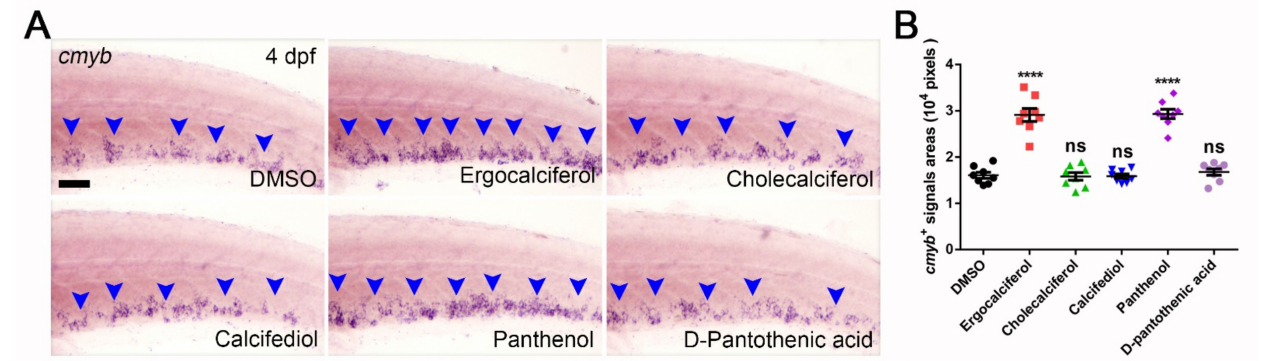
Figure 5. Comparison of the analog effects of ergocalciferol and panthenol. ( A ) WISH of cmyb after treating with ergo- calciferol and its analogs (cholecalciferol and calcifediol) as well as panthenol and its analog (D-pantothenic acid). Blue arrowheads indicate cmyb + signals. ( B ) Statistical data of ( A ) (Pixels; DMSO, 16,090 ± 659; Ergocalciferol, 29,110 ± 1399; Cholecalciferol, 15,840 ± 821; Calcifediol, 15,880 ± 485; Panthenol, 29,340 ± 1014; D-pantothenic acid, 16,790 ± 689). Scale bar, 50 µ m; Mean ± SEM, n = 8; ns, no significance; **** p <